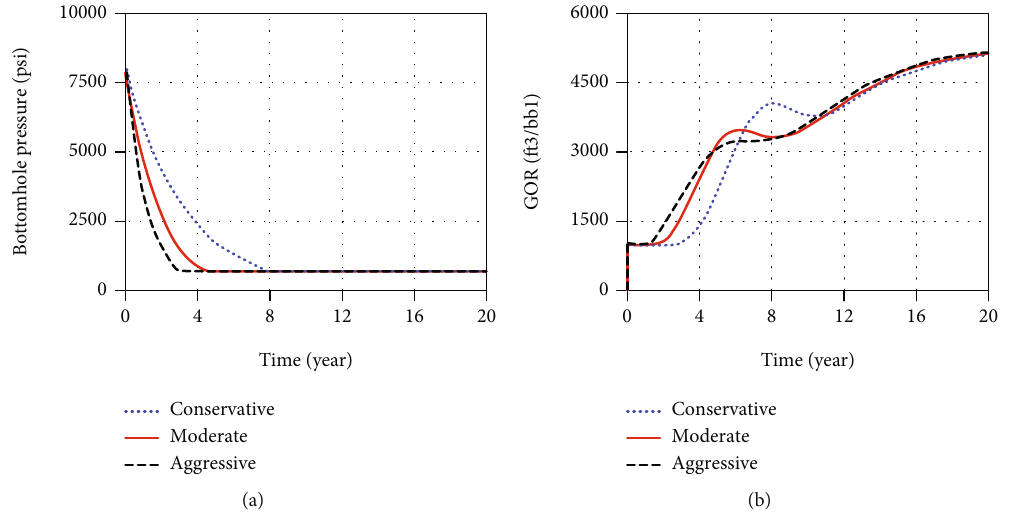
Figure 9: Simulated cases showing dependence of GOR on pressure drawdown strategy: (a) three drawdown scenarios from conservative strategy to aggressive strategy and (b) GOR responses under di ff erent pressure drawdowns.